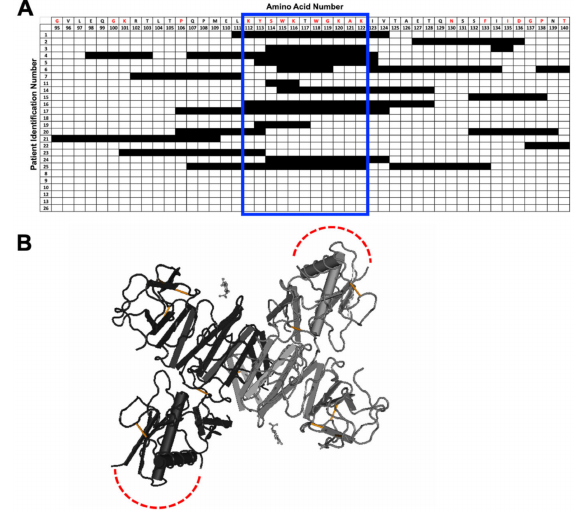
Figure 4. Individual amino acid selection for the NS1 wing domain. ( A ) Patterns of patient selection of amino acids of the wing domain of the NS1 protein were analyzed for each individual amino acid position. Patients selecting for a specific amino acid were filled in (black), and if no selection was seen for the amino acid position, the box remained unfilled. Amino acids that are conserved among all 4 serotypes of DENV are written in red along the top of the table. The regions that correlate to the wing domain have been highlighted by a blue box. ( B ) NS1 wing domain epitope is highlighted on the structure of the NS1 dimer in red (PDB: 4O6B). The wing domain is unresolved in the structure and is indicated by dotted red lines.